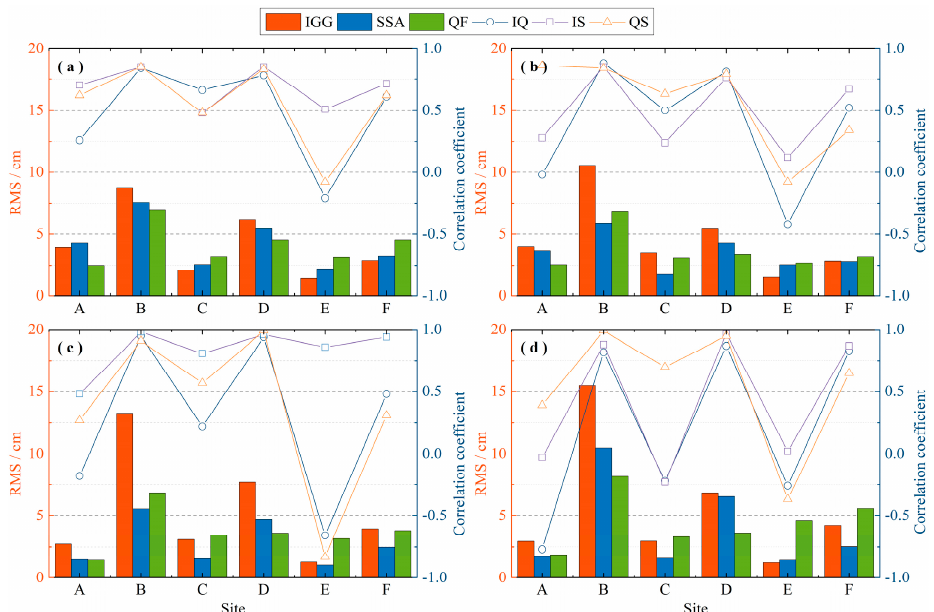
Figure 7. Comparison of correlations and RMS values at six sites with large differences in their rRMS values (see Figure 6 for locations). The analysis was performed over four time periods: ( a ) January 2003 to December 2018; ( b ) January 2016 to June 2017; ( c ) July 2017 to May 2018; ( d ) June 2018 to December 2018. IQ, IS, and QS represent the correlations between IGG and QF, IGG and SSA, and QF and SSA time series, respectively. The bars and series represent the RMS values and correlation coefficients,